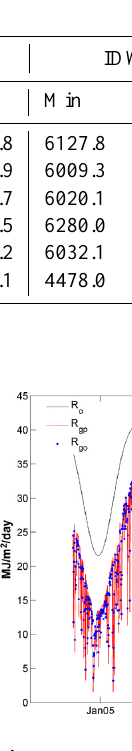
Table 4. Maximum, minimum, mean and standard deviation (MJm − 2 year − 1 ) of annual solar radiation estimates in the watershed obtained by the topographic approximation and IDW to the annual accumulated values measured at stations with daily available datasets (601, 602, 603, 702 and 802).